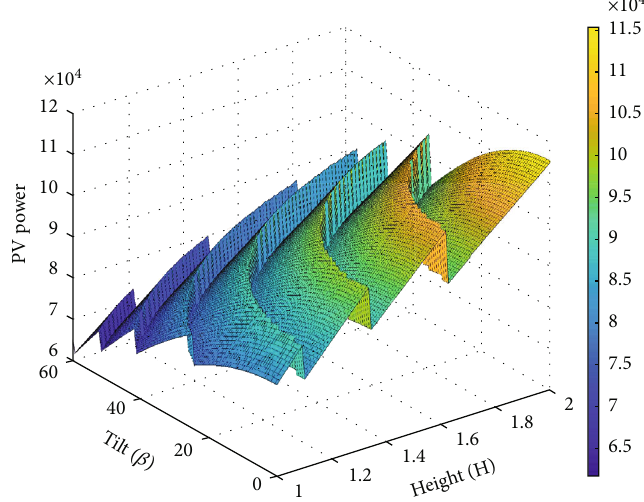
Figure 5: The e ff ect of SPV row height ( H ) on the SPV